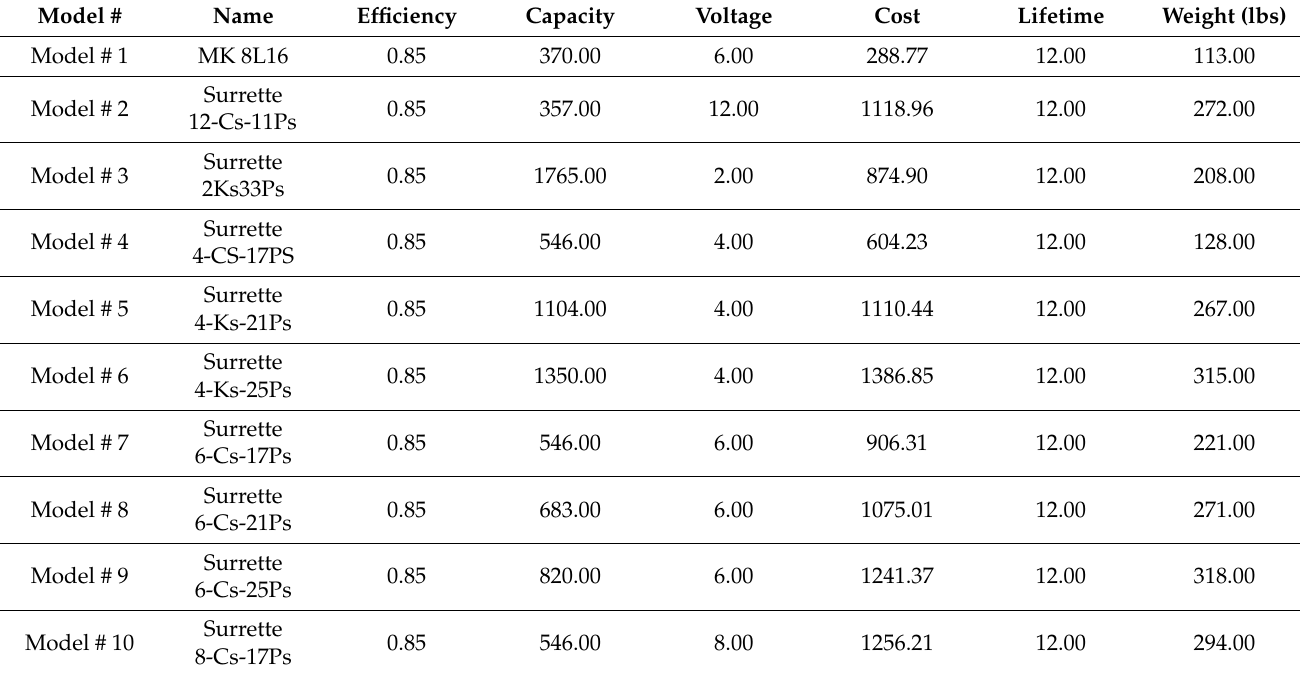
Table A2. Batteries models and information